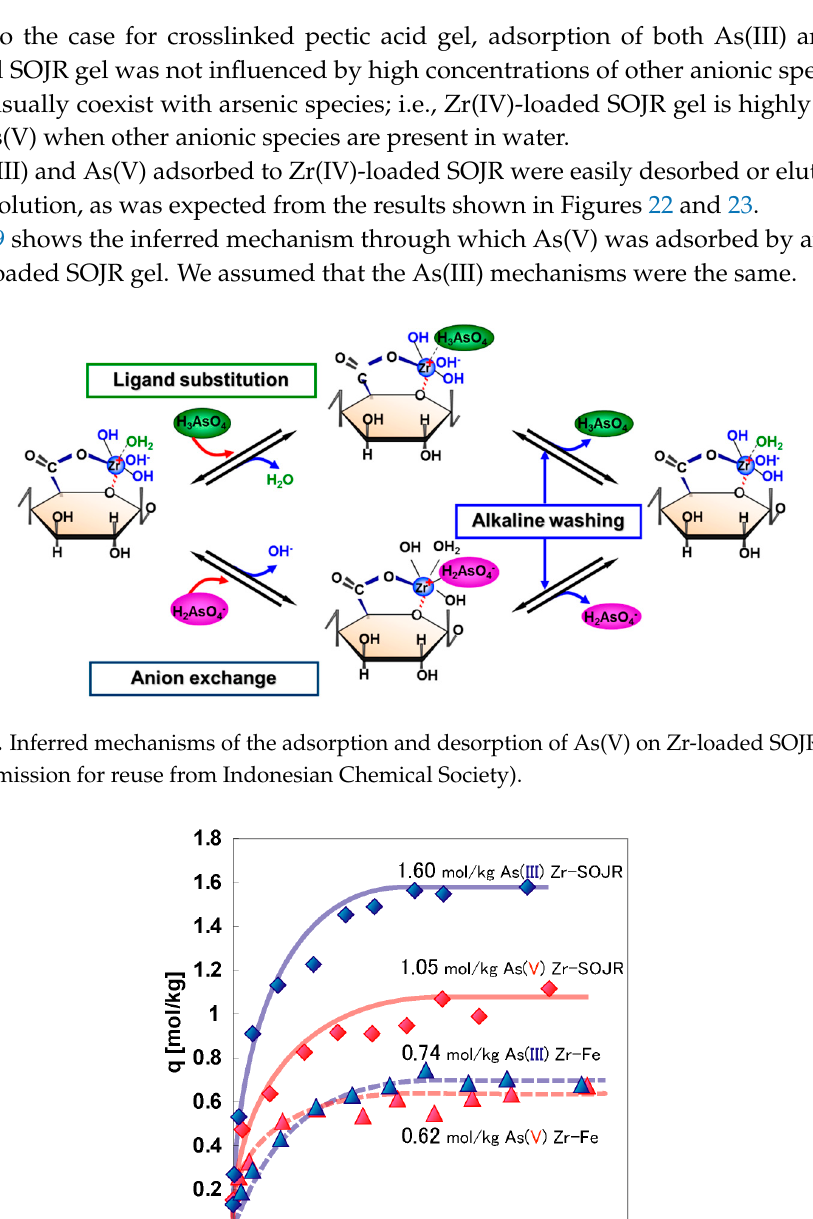
Figure 25. Isotherms for the adsorption of As(III) and As(V) by Zr(IV)-loaded SOJR and by zirconium ferrite (Zr-Fe) at 30 °C . Adsorbent mass = 25 mg, test solution volume = 15 mL, adsorption pH for As(V) = pH 3, adsorption pH for As(III) = pH 10 [16]. (With permission for reuse from Indonesian Chemical Society).